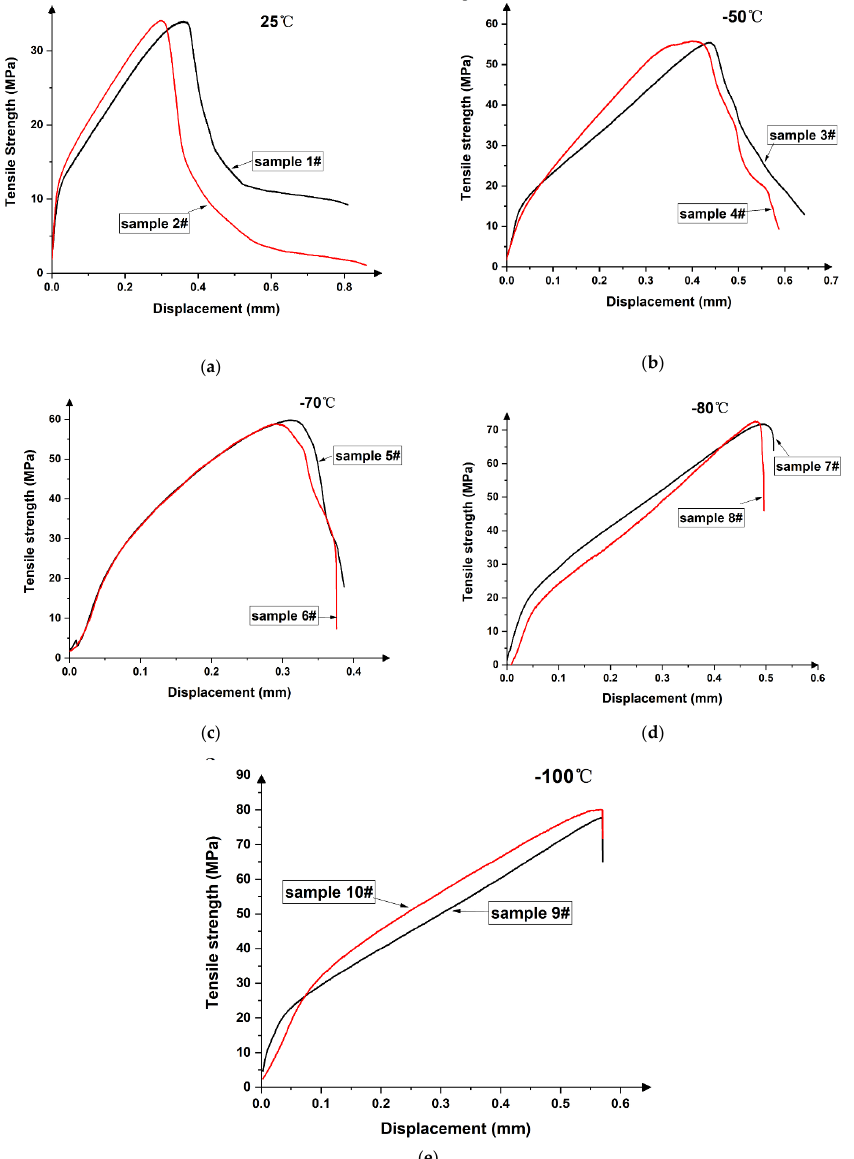
Figure 11. Tensile strength-displacement curve of Sn3.0Ag0.5Cu solder joints at different ( a ) 25 ◦ C; ( b ) − 50 ◦ C; ( c ) − 70 ◦ C; ( d ) − 80 ◦ C; ( e ) − 100 ◦ temperatures ( a ) 25 °C; ( b ) −50 °C; ( c ) −70 °C; ( d ) −80 °C; ( e ) −100 °C .